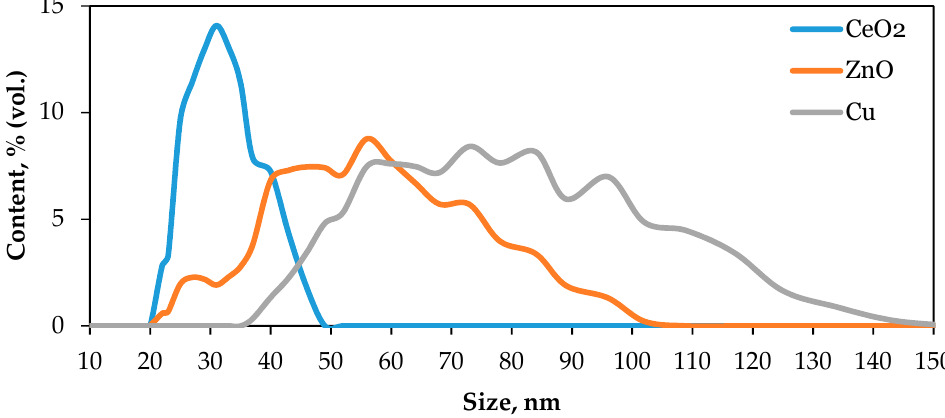
Figure 2. Size distributions of CeO 2 , ZnO, and Cu NPs in the suspensions prepared for spiking the soil.